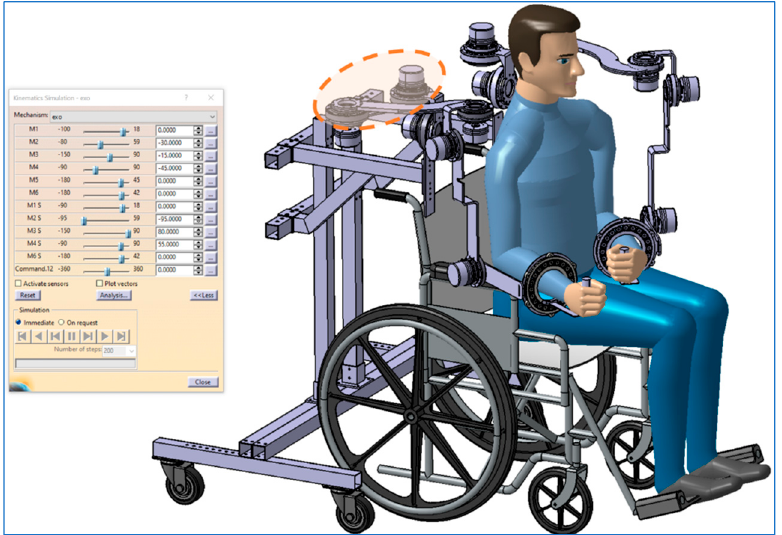
Figure 4. J2 and J3 joints’ range and mechanical structure of the CardioVR-ReTone exoskeleton. (Catia software capture)